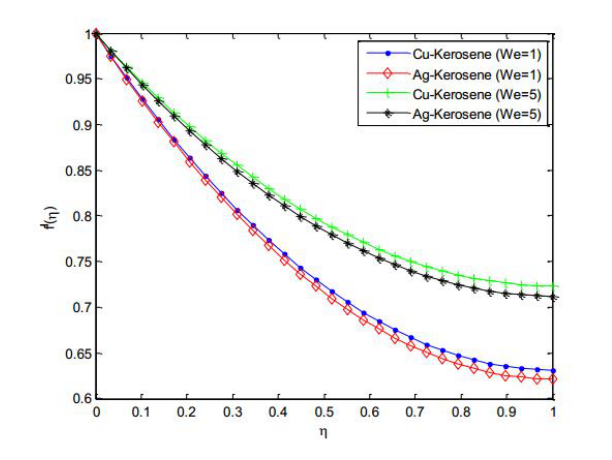
Figure 10. Effect of Weissenberg number on the fluid velocity distribution